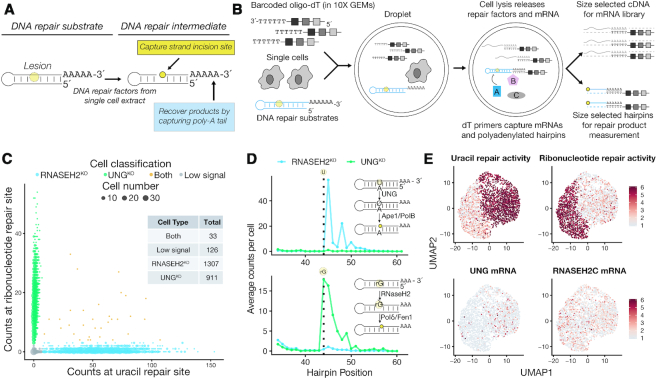
Development and validation of a single-cell assay for measuring DNA repair capacity. (A) Schematic of DNA repair substrates used in single-cell Haircut. Strand incision generates a new 5′-end whose position is captured by cDNA synthesis with barcoded oligonucleotides. (B) Overview of single-cell Haircut. After droplet formation, cell lysis creates a ∼50 pl reaction wherein enzymes contributed by the cell catalyze substrate turnover (i.e. strand incision for specific DNA repair substrates). Repair products and mRNAs are converted to cDNA with barcoded oligo-dT primers and separated by size to enable separate library preparations. The cDNA for each fraction is analyzed to identify the cell barcode and either mRNA abundance or the amount of enzymatic activity (i.e., number of strand incisions). (C) Polyadenylated hairpins containing a single uracil or ribonucleotide (25 nM each) were added to a single-cell suspension of a mixture of Hap1 cells containing null alleles of either UNG or RNASEH2C prior to capture in a 10x Genomics 3′ Gene Expression experiment. Sequences from the DNA repair fraction in (B) were grouped based on their cell barcodes, and the level of strand incision for uracil and ribonucleotide substrates was used to classify cells as either UNGKO (green) or RNASEH2CKO (blue) based on strand incision activity (UMI counts at position 44 for ribonucleotide, position 45 for uracil) >5% of the maximum for all cells. Cells that fall on the x- or y-axis are single RNASEH2CKO and UNGKO cells, respectively; doublets are in yellow; and cells with low signal (<5% of the max for both activities) are in grey. (D) Aggregate counts of strand incision events are plotted against hairpin position for cells classified in (C) on the U:A substrate (top) and rG:C substrate (bottom). The vertical dashed line notes the position of the uracil and ribonucleotide (position 44 in both cases). UNGKO cells fail to incise uracil-containing hairpins (green line in top panel) and RNASEH2CKO cells fail to incise ribonucleotide-containing hairpins (blue line in bottom panel). The predominant signal at position 45 (top) reflects UNG conversion of the uracil (position 44) to an abasic site, followed by removal of the abasic site by Ape-1 or Pol β. The predominant signal at position 44 (bottom) reflects 5′-incision of the ribonucleotide at position 44 followed by copying of the rG template by reverse transcriptase in the droplet. Additional processing of incised repair intermediates yields signals at positions 3′ of the lesion (signals at positions 46–50 in the uracil substrate (top), and positions 45–50 in the ribonucleotide substrate (bottom)). (E) Variable mRNA expression from cells classified in (C) was used to calculate a UMAP projection (identical coordinates in all four panels). Uracil repair activity (natural logarithm of strand incision counts (position 45 for uracil substrate and position 44 for ribonucleotide substrate; (D) divided by total counts for that cell multiplied by a scaling factor of 104; top left) and ribonucleotide repair activity (top right) were superimposed in a gray-to-red scale and delineate two major cell types in the experiment; 90% of cells in each class have a scored activity. Levels of UNG and RNASEH2C mRNA (natural logarithm of mRNA counts divided by total counts for that cell multiplied by a scaling factor of 104) are plotted on the bottom panels are not sufficient to classify cell types. Stabilization of the null-mutation-containing RNASEH2C mRNA yields uniform RNASEH2C mRNA detection across both cell types.